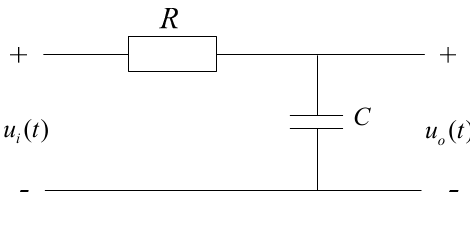
Figure 3. Equivalent circuit of LFA.